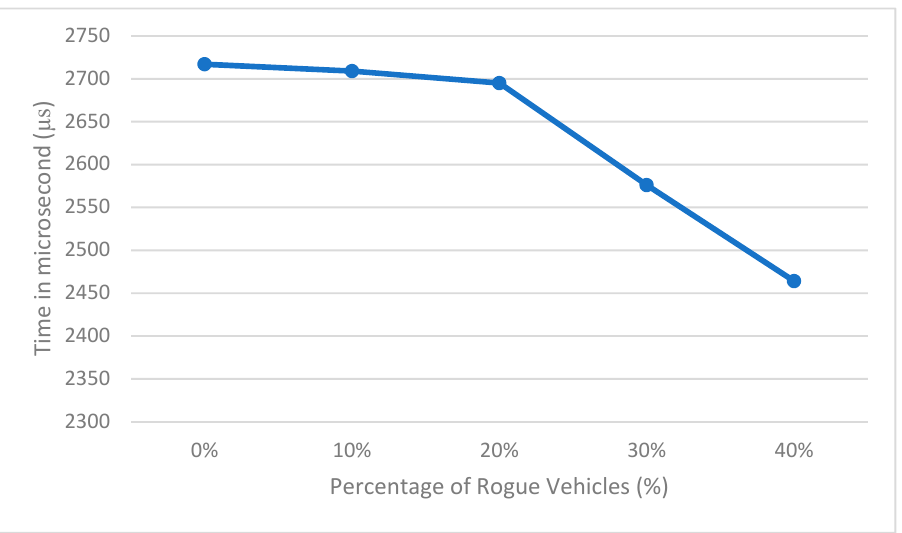
Figure 4. Data processing time with different percentage of rogue vehicles.